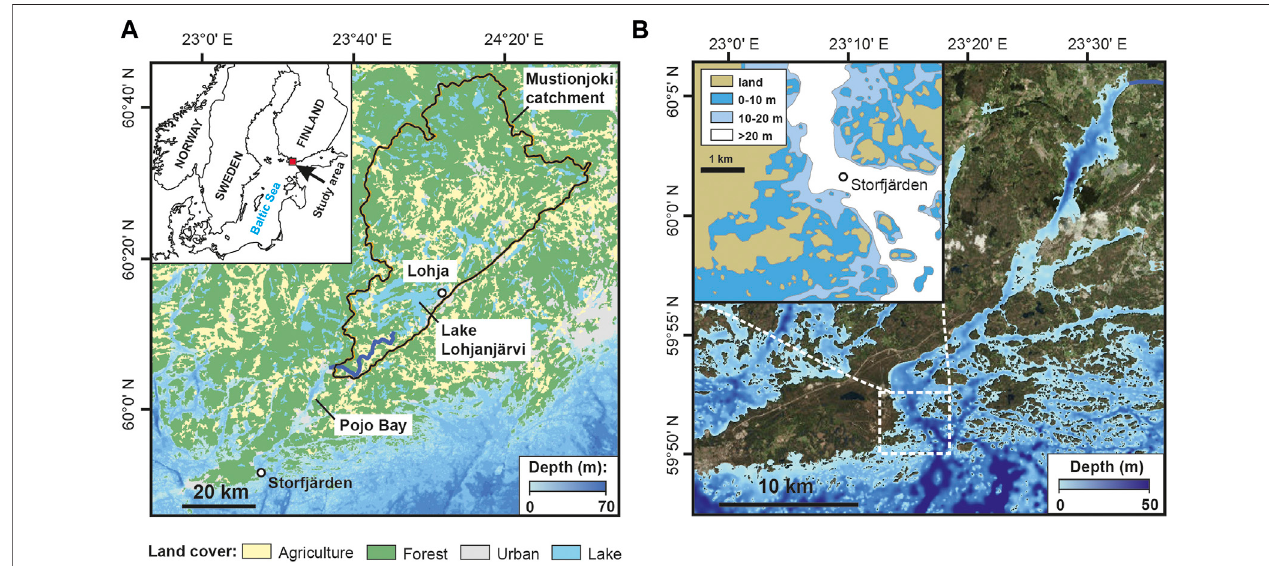
FIGURE1| Locationofthestudy. (A) (inset)StudyareainthenorthernBalticSea.(main)CatchmentoftheMustionjokiriver(black)showingthelocationofthecityof Lohja andadjacent LakeLohjanjärvi.BluelineshowstheMustionjokiriveritself,connectingthecatchmenttothePojoBayestuarinesystemdrainingintoStorfjärden. (B) (main) location of Storfjärden at the southern end of the estuary. (inset) zoom of the coring location in Storfjärden.